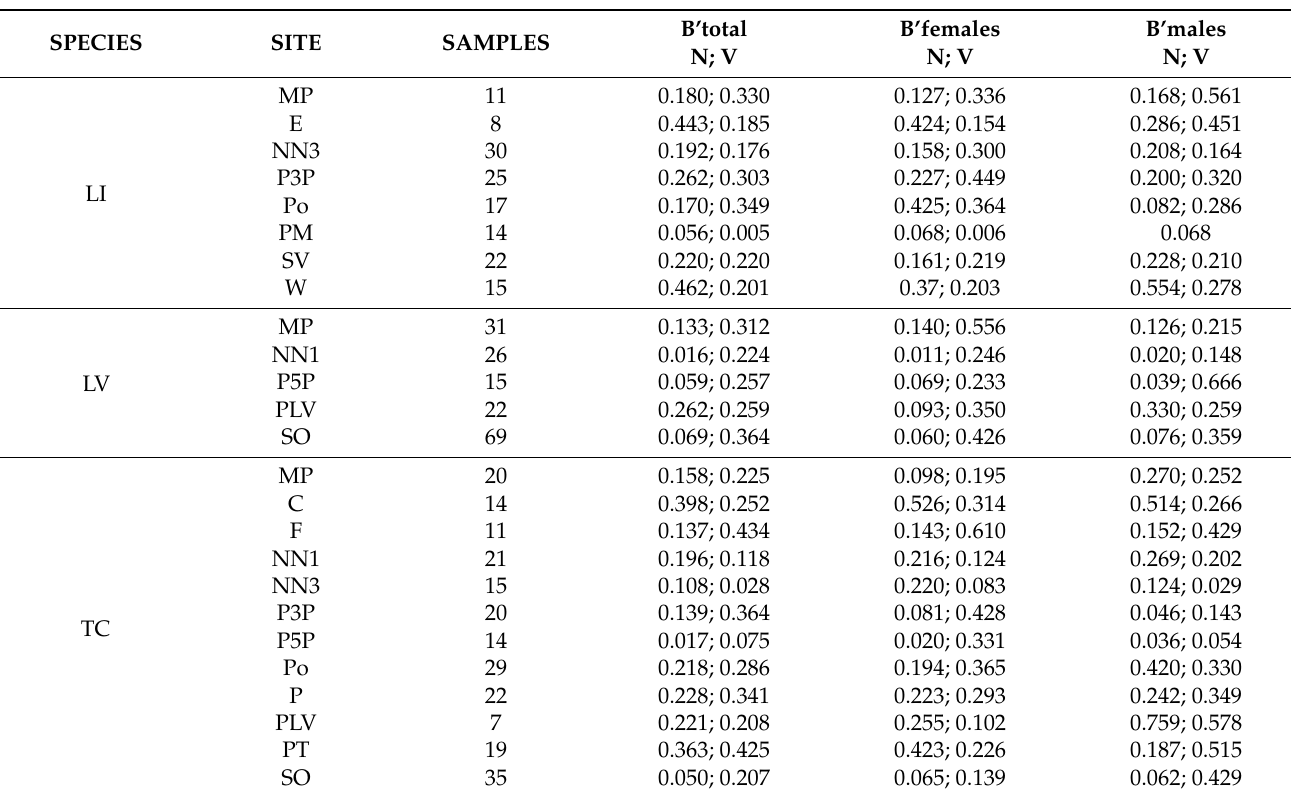
Table 2. Hurlbert niche (B’) width values based on prey number (N) and volume (V) of Lissotriton italicus (LI), Lissotriton vulgaris (LV) and Triturus carnifex (TC) and of females and males from all the study sites.